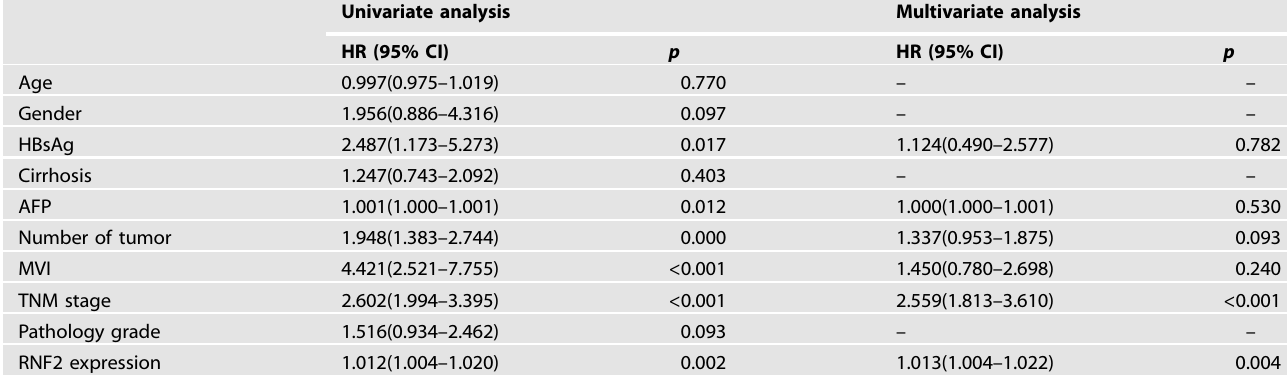
Table 2. Cox regression analysis of overall survival (OS) in 83 patients with